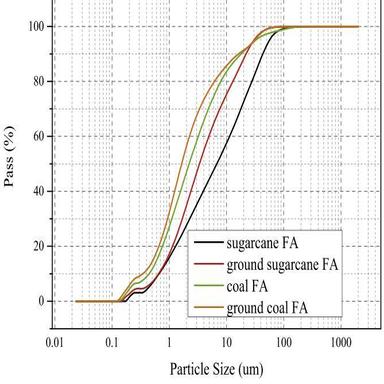
Particle size distributions of the raw and ground SCBA and CFA.